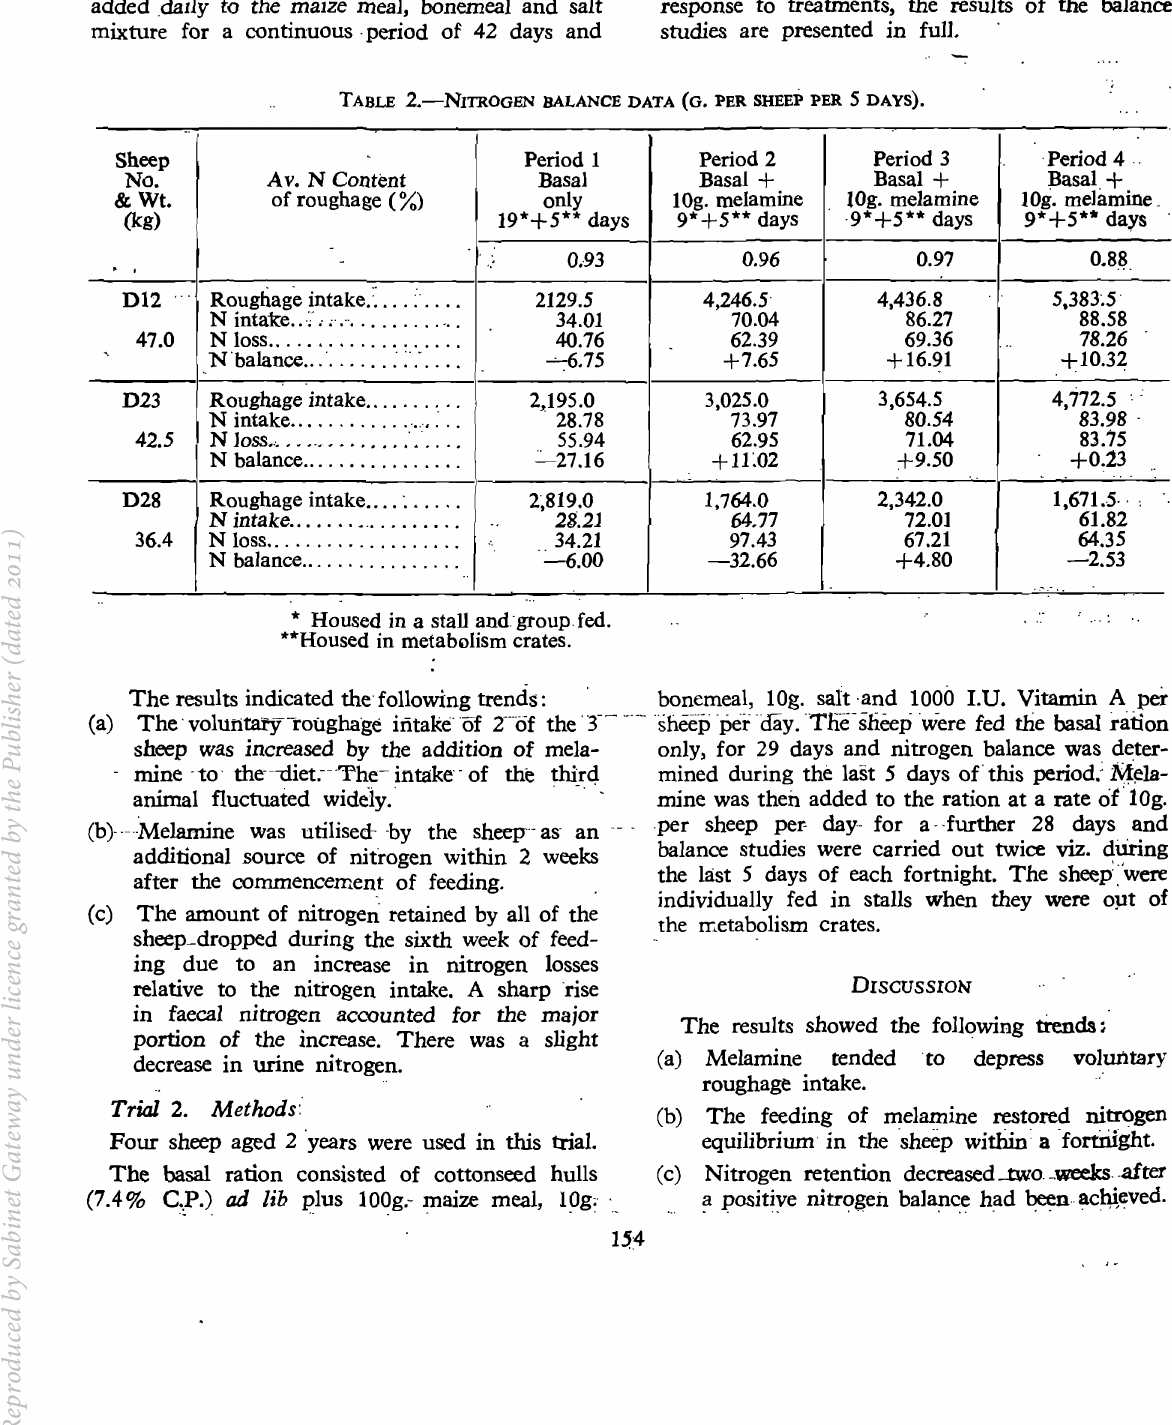
TABLE 2.-NITROGEN BALANCE DATA (G. PER SHEEP PER 5